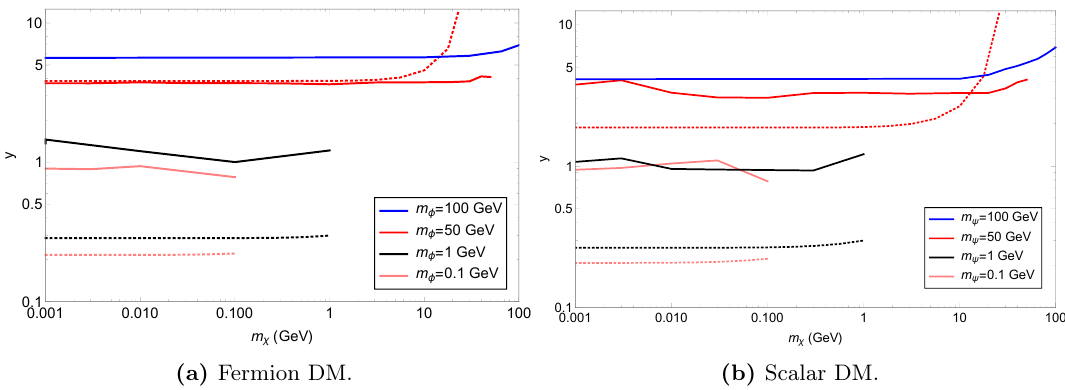
Figure 8. The 90% CL bounds on the DM-neutrino coupling y from the LHC mono-lepton search (solid line) and the invisible Z decay width (dotted line). The collider bounds are subjected to y 4 (cid:25) and m (cid:31) m (cid:30) ( ) (cid:20) (cid:20)